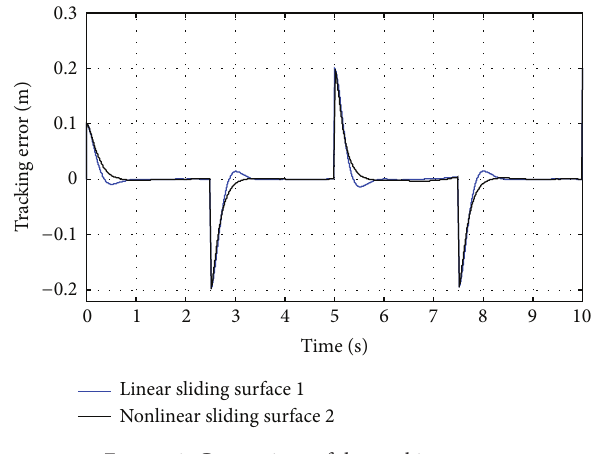
Figure 7: Step response using different sliding surface.